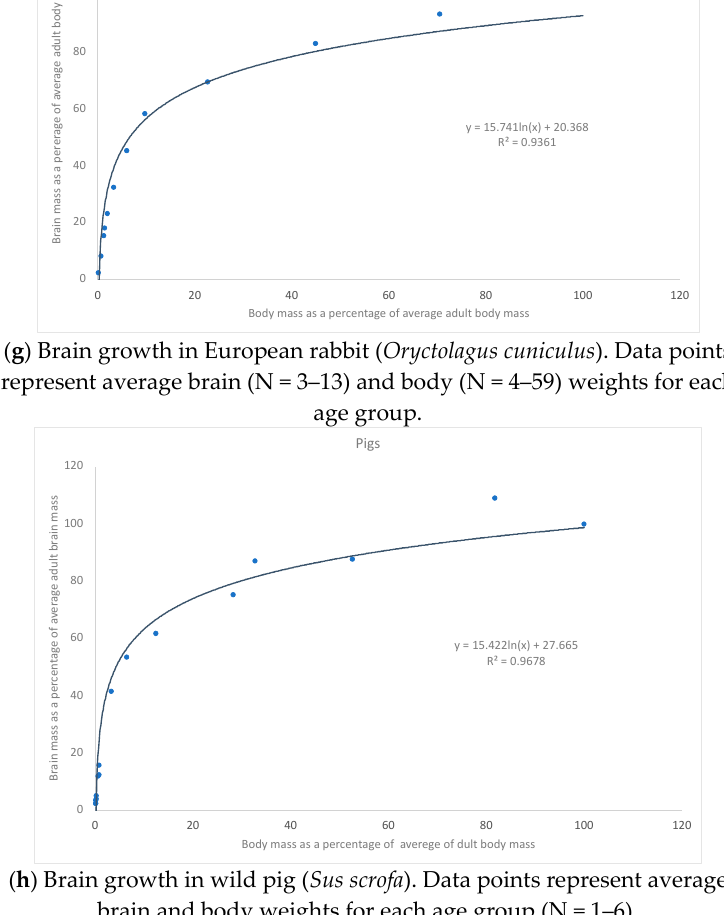
brain and body weights for each age group (N = 1–6).